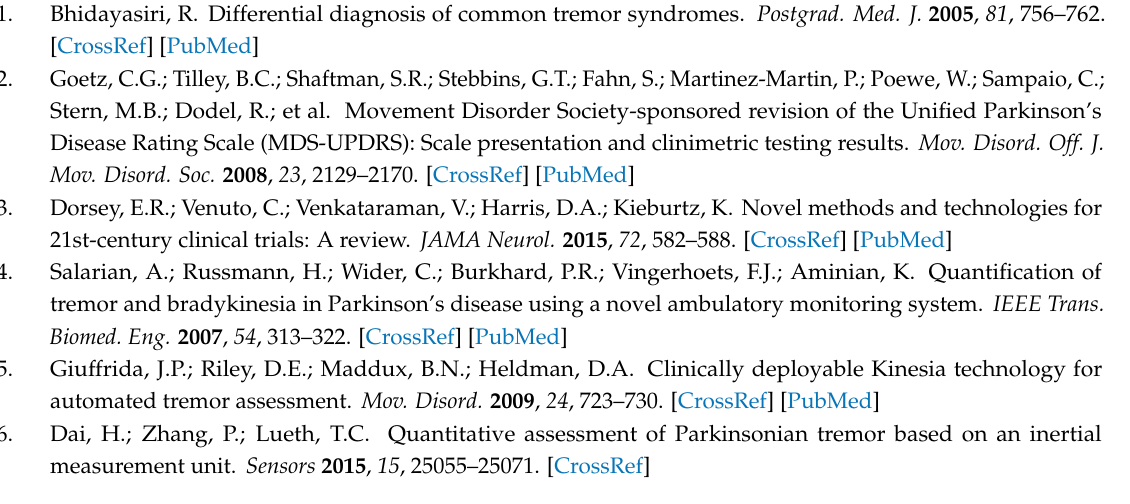
s1, Figure S1: A. Schematic of the leave-one-subject-out cross-validation. B. Data split for training a model and hyperparameters’ adjustments at every